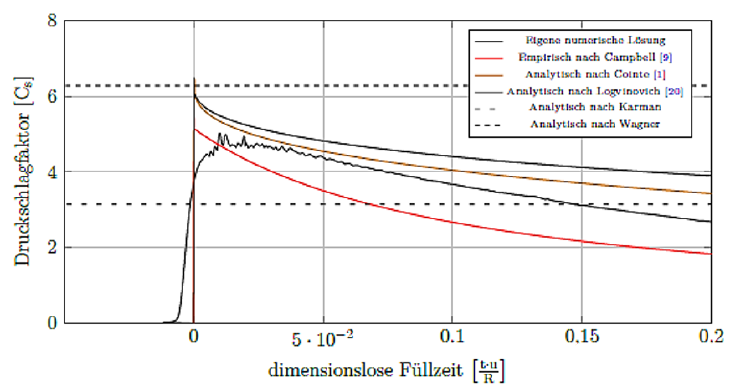
Figure 9. Comparison of the computed result with reference studies in previously published articles; mesh cell spacing 0.025